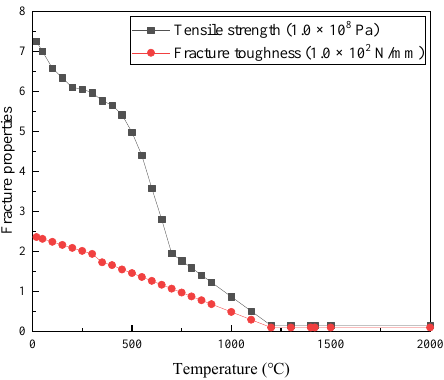
Figure 10. Temperature-dependent fracture properties for P91 steel, used in the FE simulation, data from [35,36].